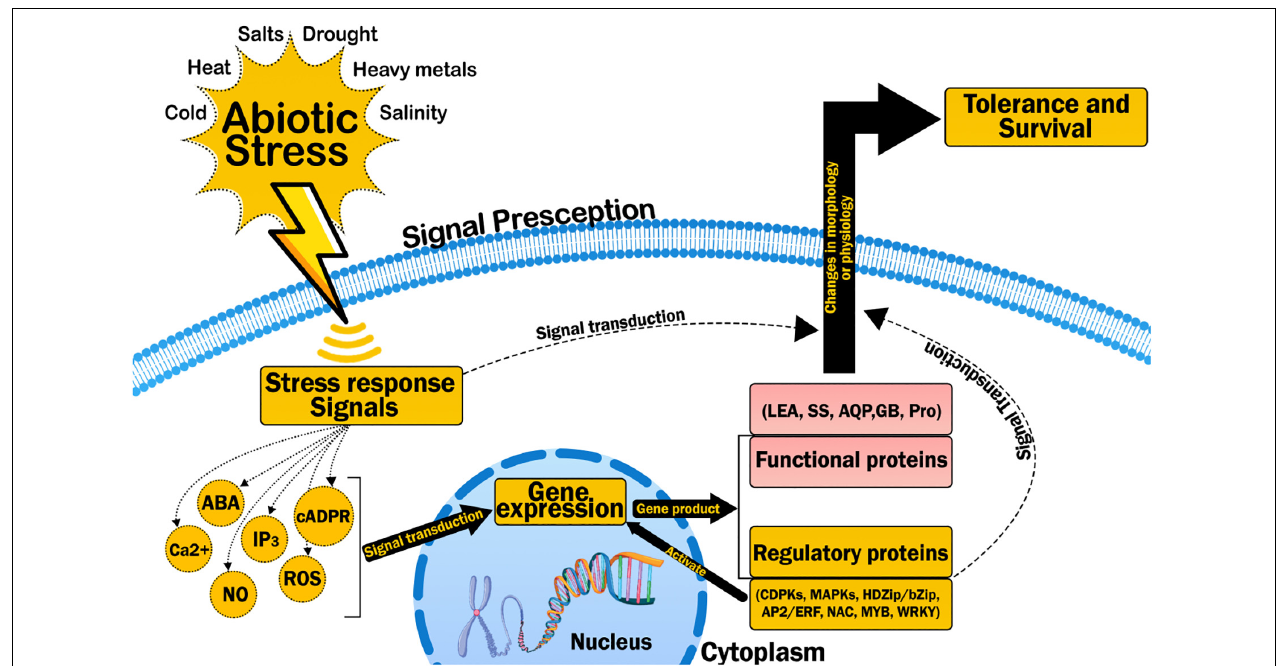
FIGURE 4 | Activation of stress response genes and finally stress response is engineered by expression of these